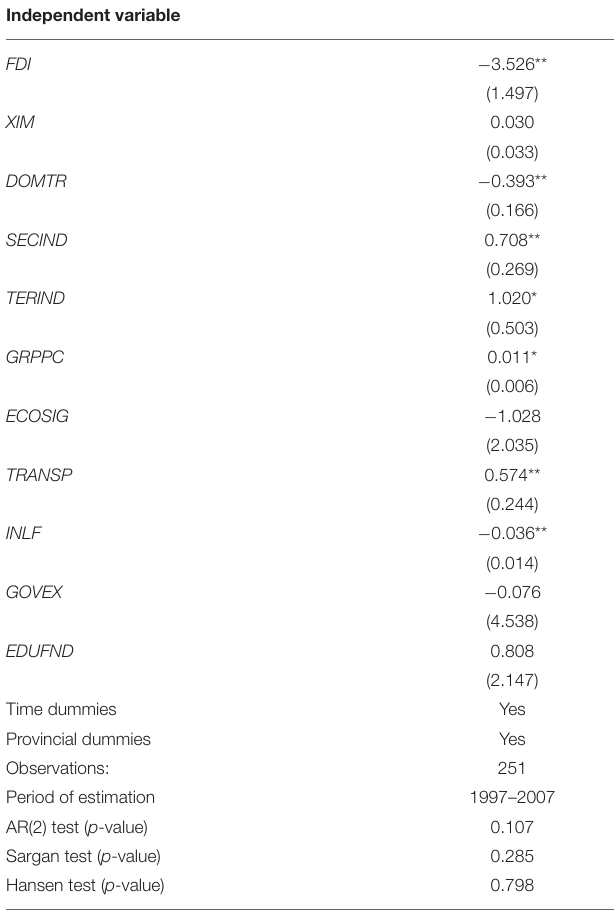
TABLE 2 | Regional inequality and globalization. Independent